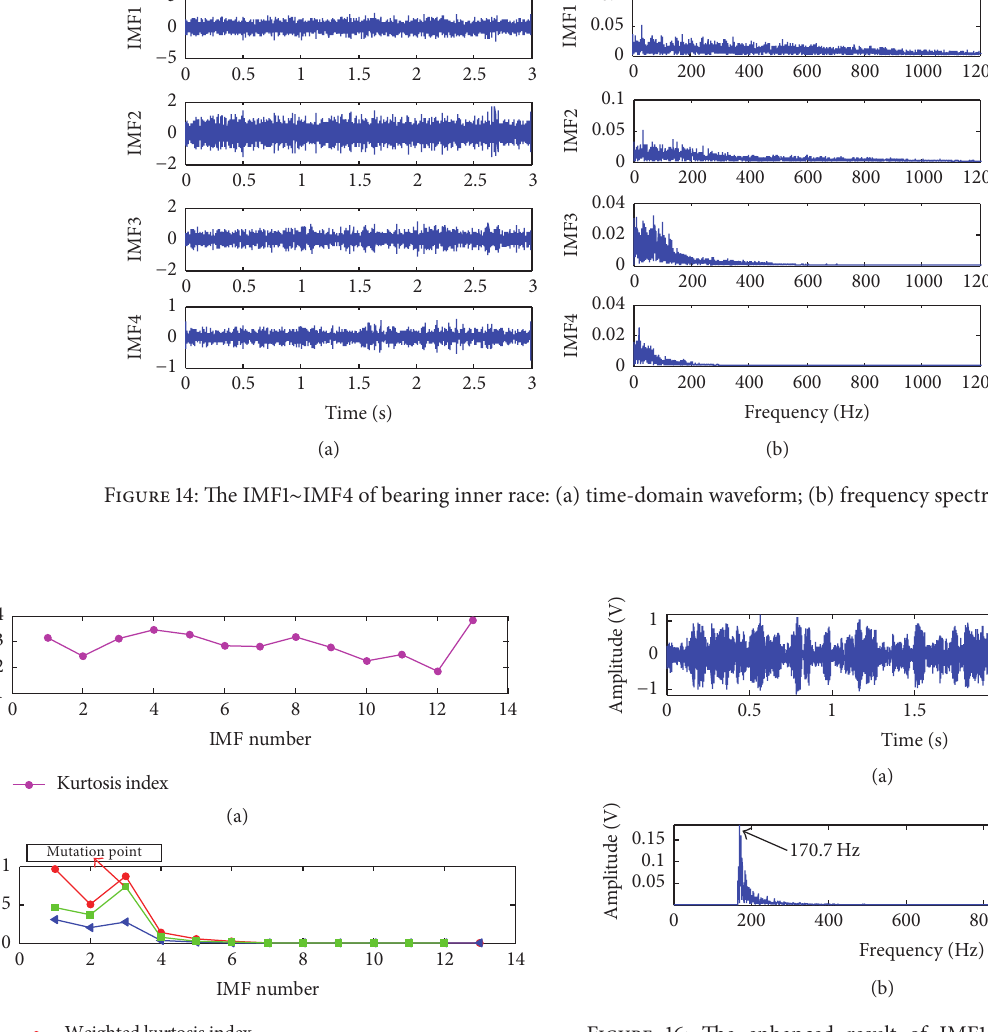
Figure 16: The enhanced result of IMF1 with an inner fault via adaptive stochastic resonance: (a) time-domain waveform; (b) frequency spectrum.